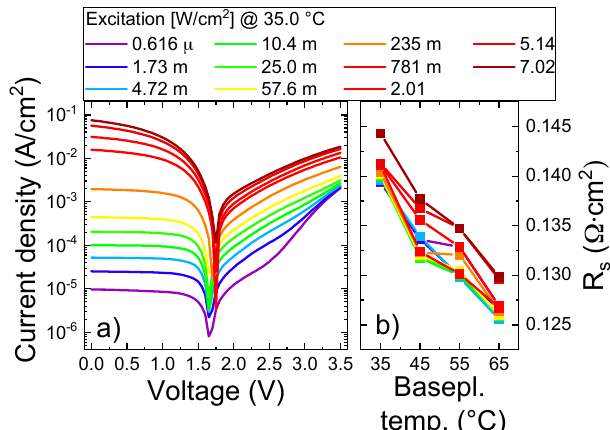
Figure 2. External quantum efficiency of the device at various wavelength ( a , b ) and external quantum efficiency at 478 nm at various baseplate temperatures ( c ).